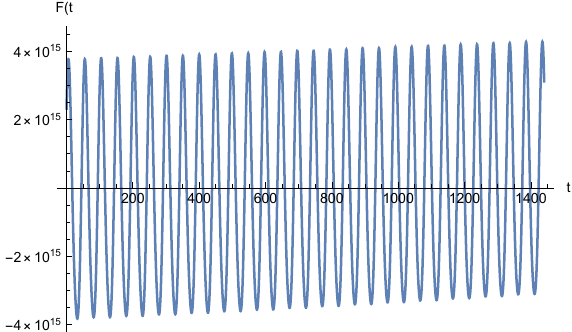
Fig. 2 Visibility Intervals Between AQUA and ARIRANG2 during 24-H